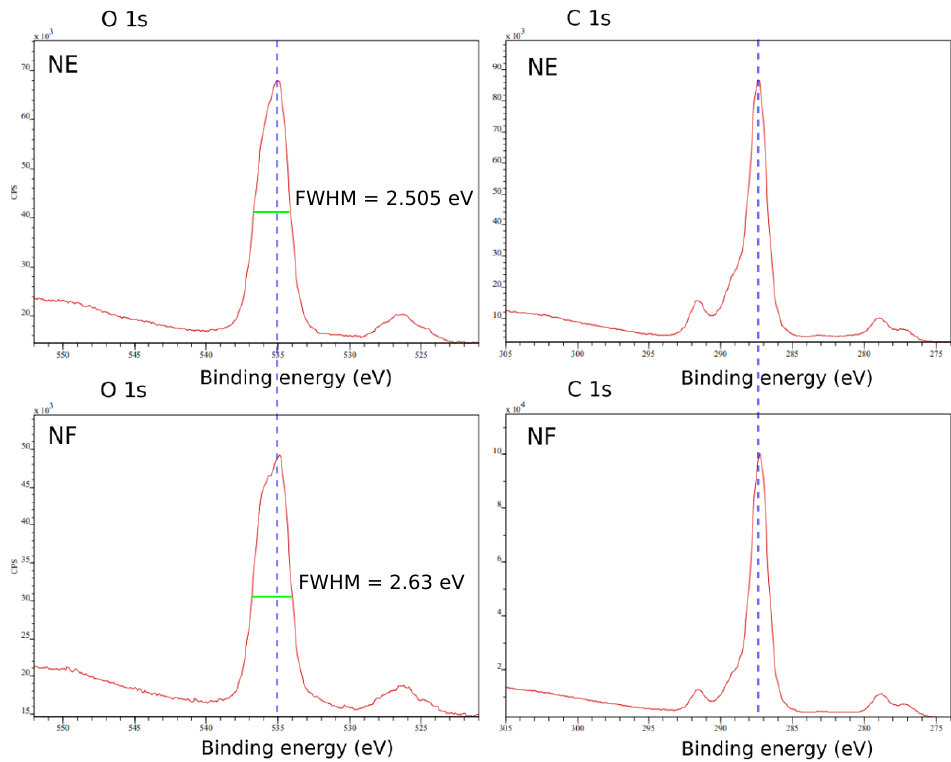
Figure 9. High-resolution XPS spectra of the O 1s ( left ) and C 1s ( right ), performed on paper